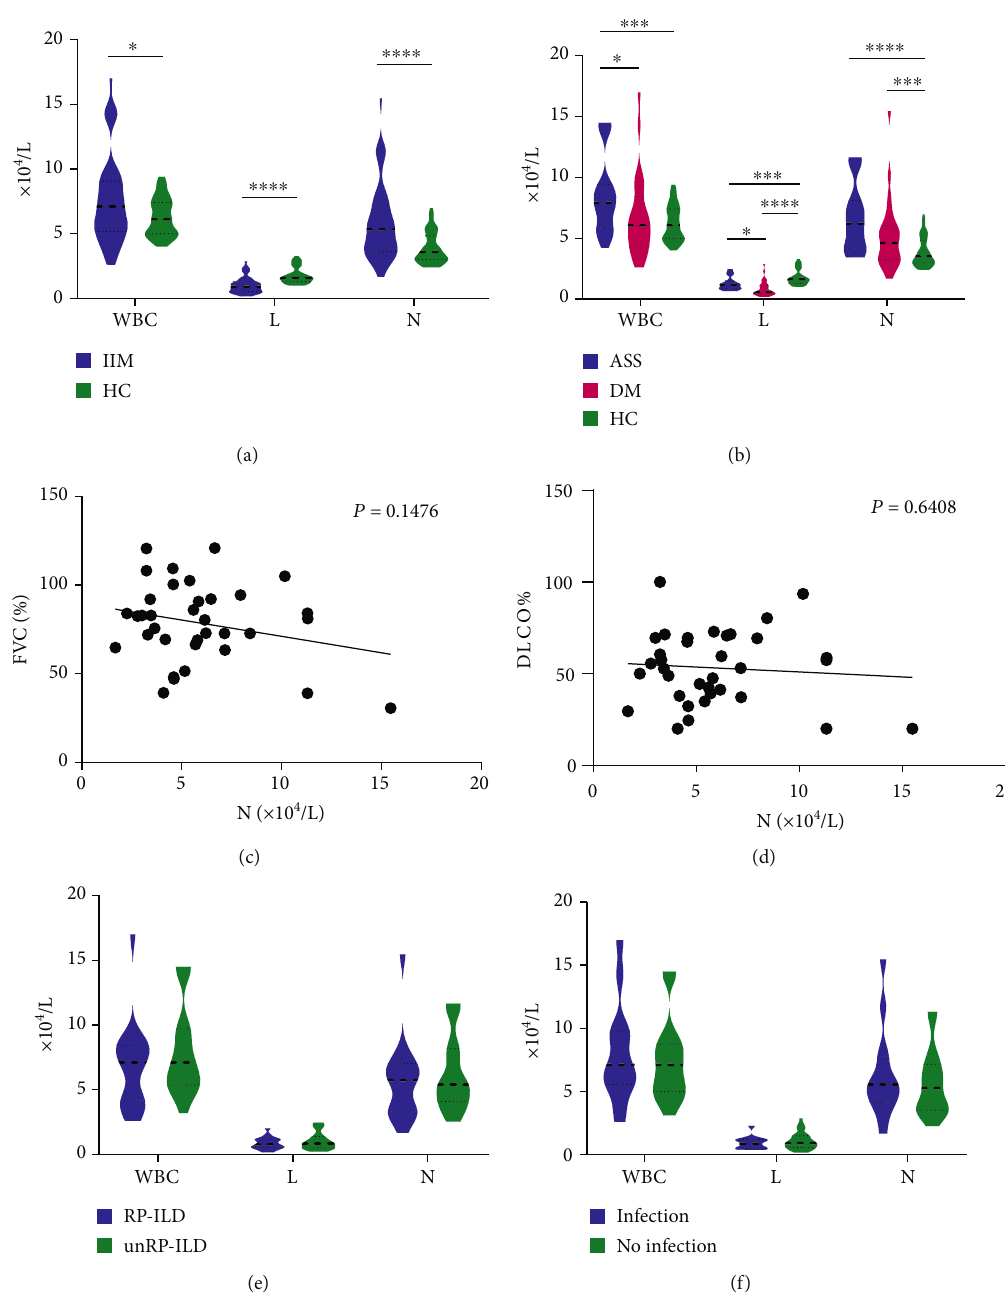
Figure 1: WBC, lymphocytes, and neutrophils in IIM patients and relationship with lung diseases. (a) Compared to healthy controls (HC), patients with IIM had signi fi cantly higher WBC counts ( P = 0 : 023 ) and neutrophil counts ( P < 0 : 0001 ), but lower lymphocyte counts ( P < 0 : 0001 ). (b) ASS patients had higher WBC counts than healthy controls ( P < 0 : 001 ) and DM patients ( P = 0 : 073 ), while DM patients had lower lymphocyte counts compared to both ASS patients ( P = 0 : 030 ) and healthy controls ( P < 0 : 0001 ). ASS patients ( P < 0 : 0001 ) and DM patients ( P = 0 : 008 ) had higher neutrophil counts than healthy controls. (c, d) No correlations between neutrophils and FVC% and DLCO% were seen. (e) No di ff erences in WBC, lymphocytes, and neutrophils between RP-ILD patients and other ILD patients. (f) No di ff erences in WBC, lymphocytes, and neutrophils between the presence or absence of respiratory